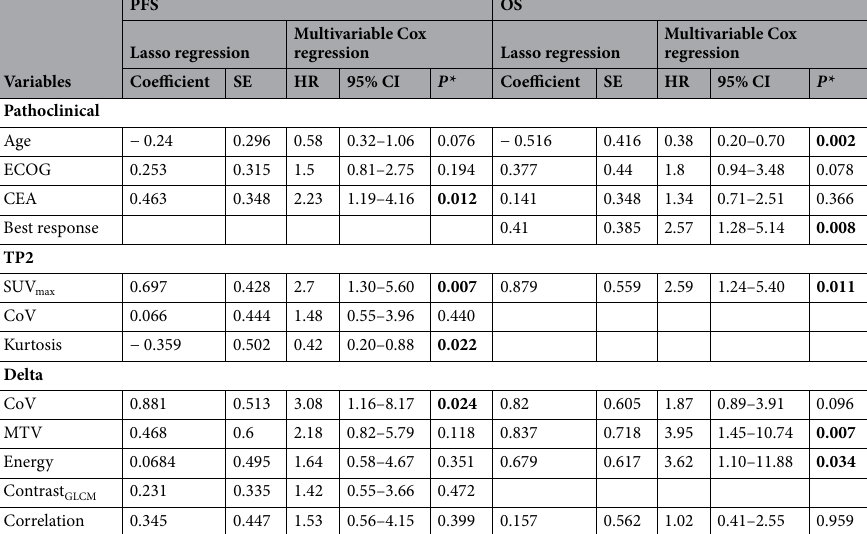
Table 2. Pathoclinical and radiomics variables selected by Lasso Cox regression model and identified by multivariable Cox regression model. PFS progression-free survival, OS overall survival, SE standard error, HR hazard ratio, CI confidence interval, SUV standardized uptake values, CoV coefficient of variation, ECOG The Eastern Cooperative Oncology Group, CEA carcinoembryonic antigen, CoV coefficient of variation, MTV metabolic tumor volume, GLCM gray-level co-occurrence matrix. Bold values denote statistical significance at the P < 0.05 level. * P value was generated by multivariable Cox proportional hazards regression